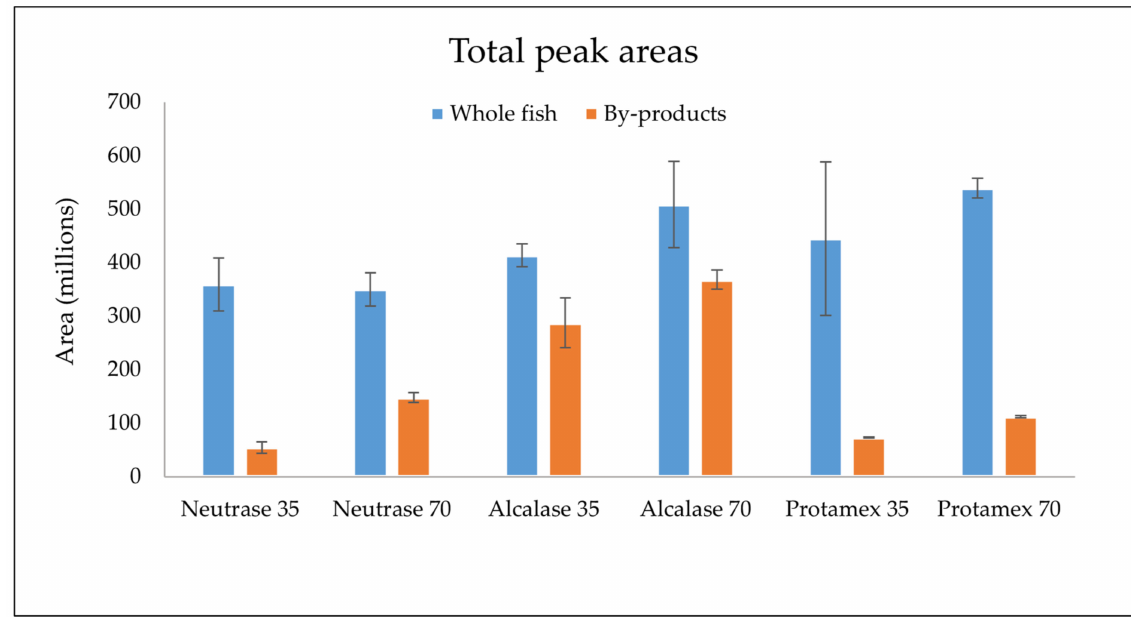
Figure 1. Total peak areas in HS-SPME-GC-MS chromatogram of all identified volatile compounds (N = 41) from different enzymatically extracted oils from whole fish (blue bars) and by-products (orange bars) of Baltic herring.